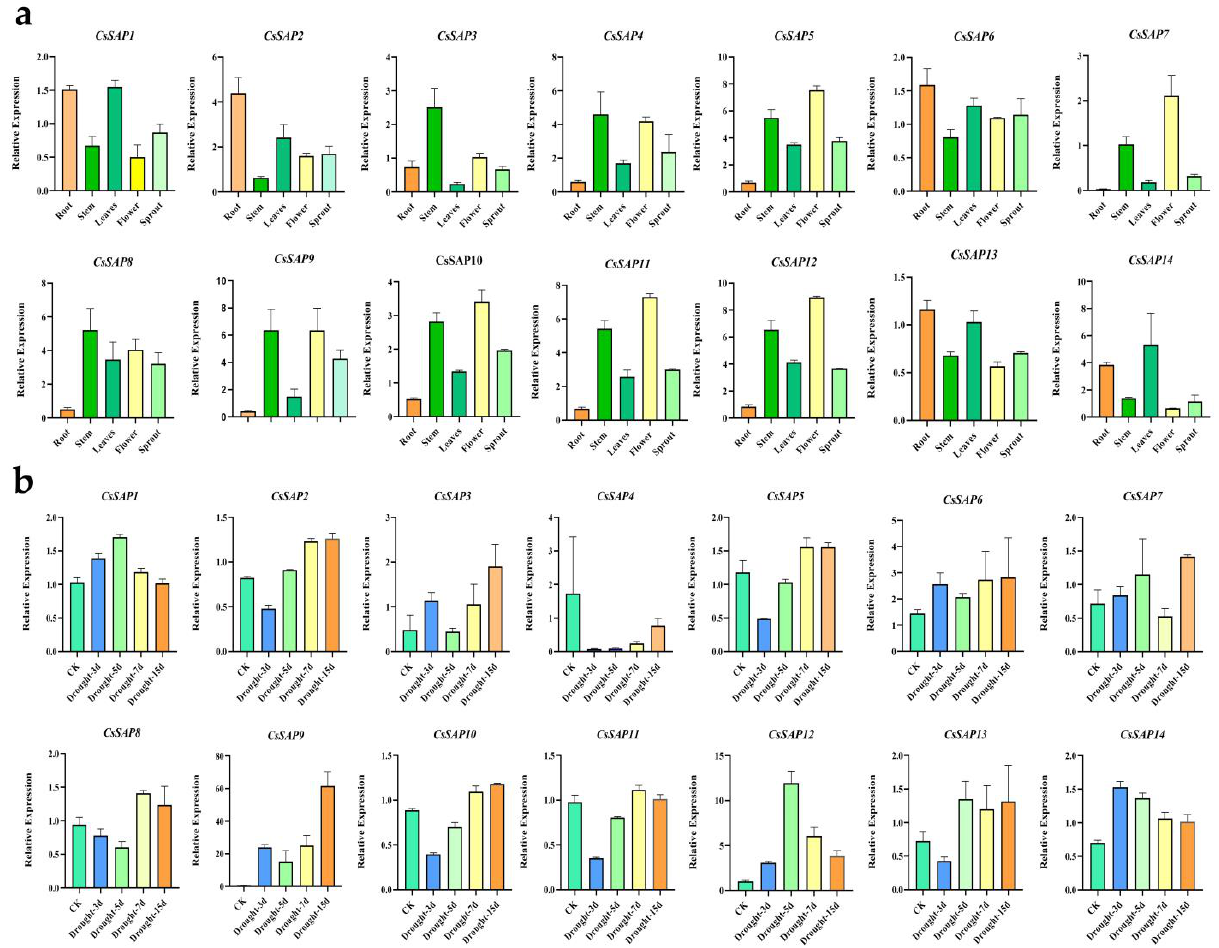
Figure 5. Tissue-specific expression and drought response of 14 CsSAPs . ( a ) Expression patterns of CsSAPs in different tissues of tea plant. ( b ) Expression patterns of CsSAPs in response to drought stress.